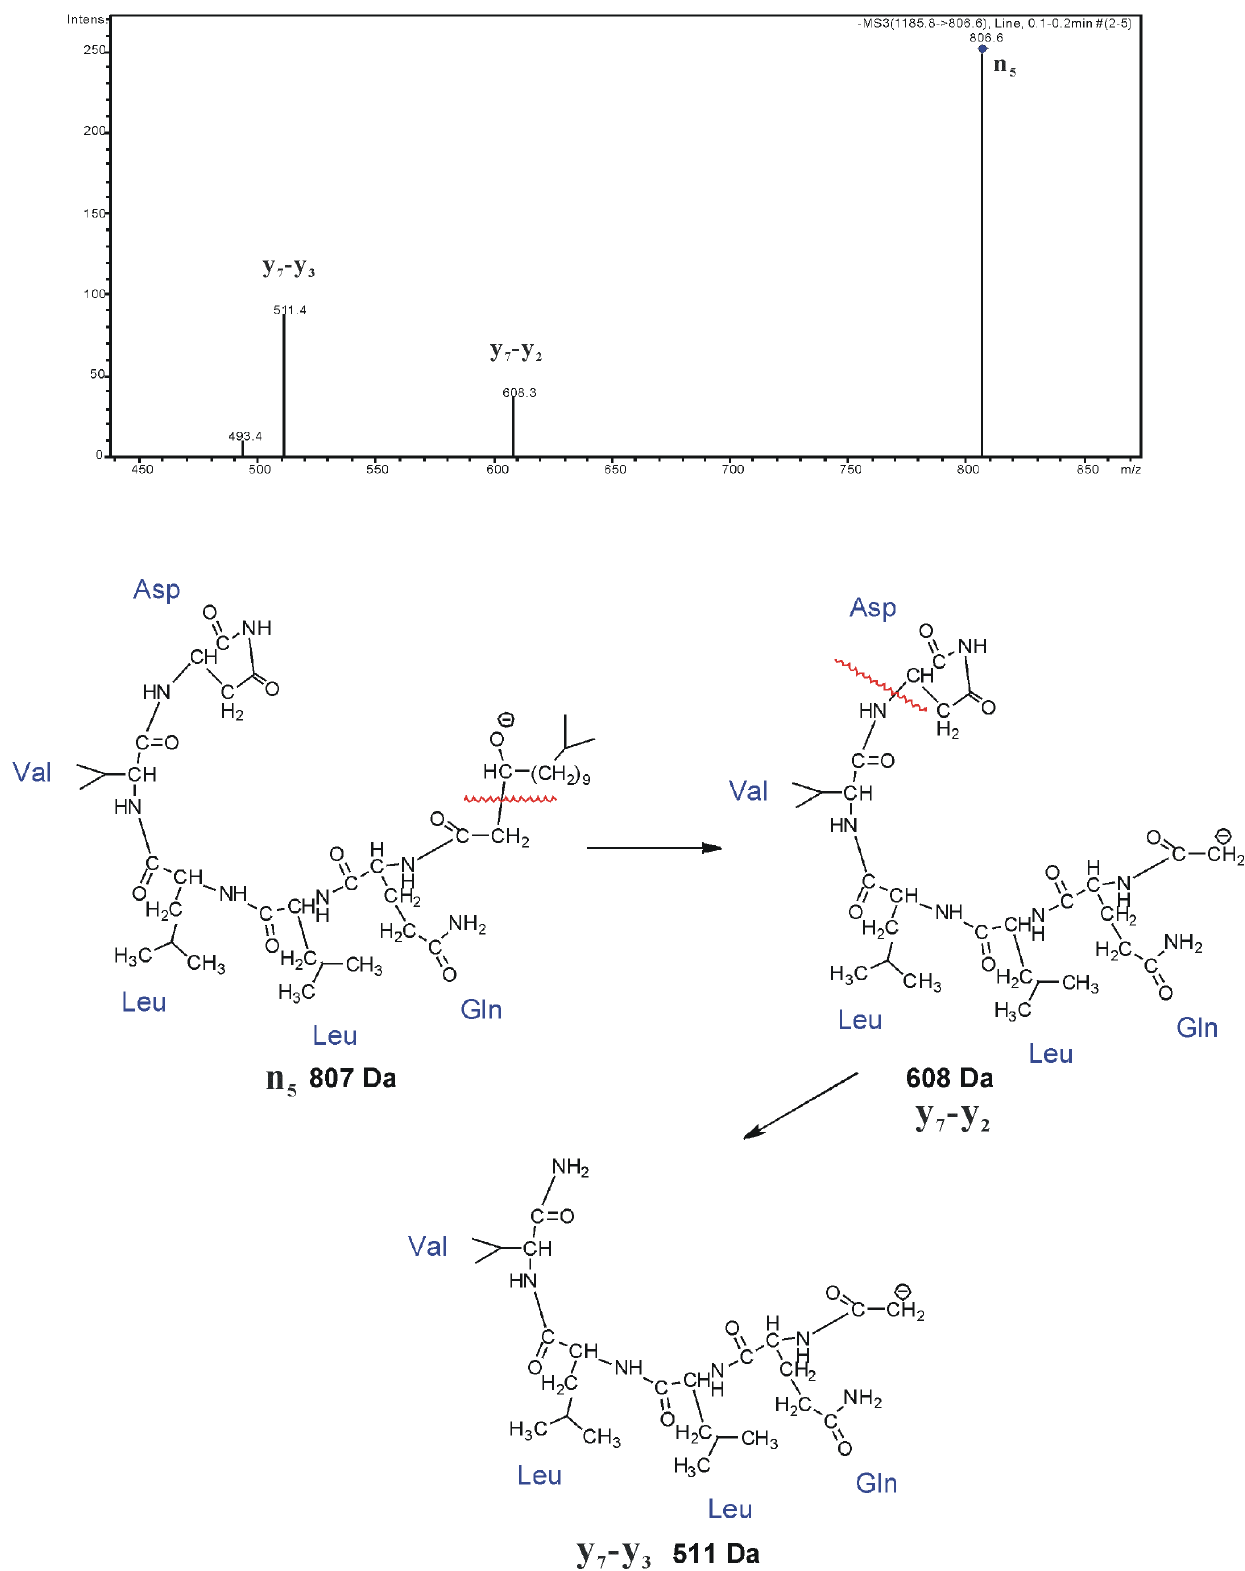
Figure 6. The MS 3 analysis and fragmentation mechanisms of n 5 (m/z 807).